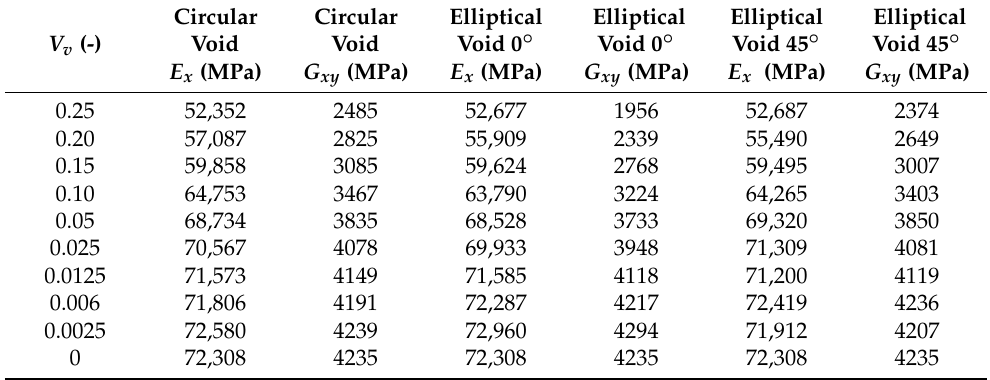
Table 7. Analytical results calculated with CLT for a cross-ply laminate based on the RVE results.